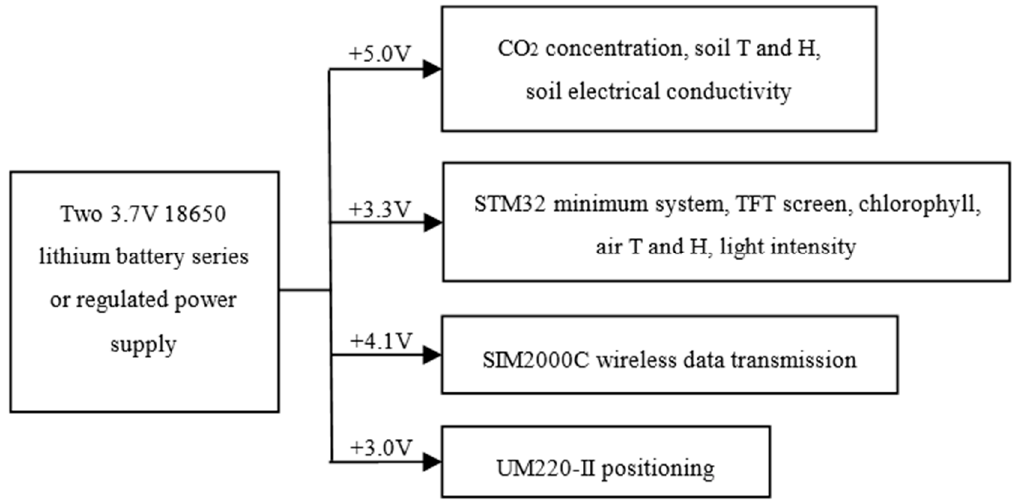
Figure 6. Block diagram of the power supply system.